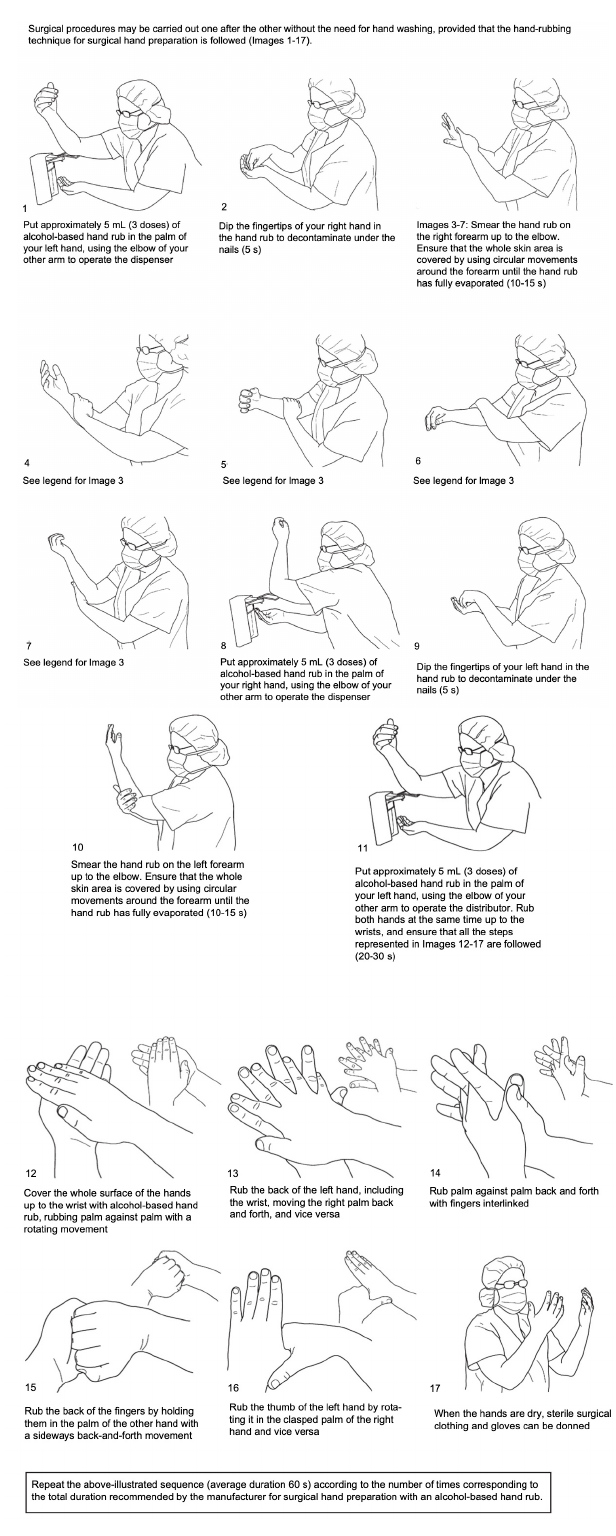
Figure 3. Hand-rubbing technique for surgical hand preparation. From WHO guidelines of hand hygiene in health care [15]. In case of contamination with blood and biological material, surgical hand washing under running water and soap is obligatory [16]. Therefore, we recommend sanitizing hands daily with alcoholic sanitizer solutions and limiting surgical hand washing only in cases of contamination.